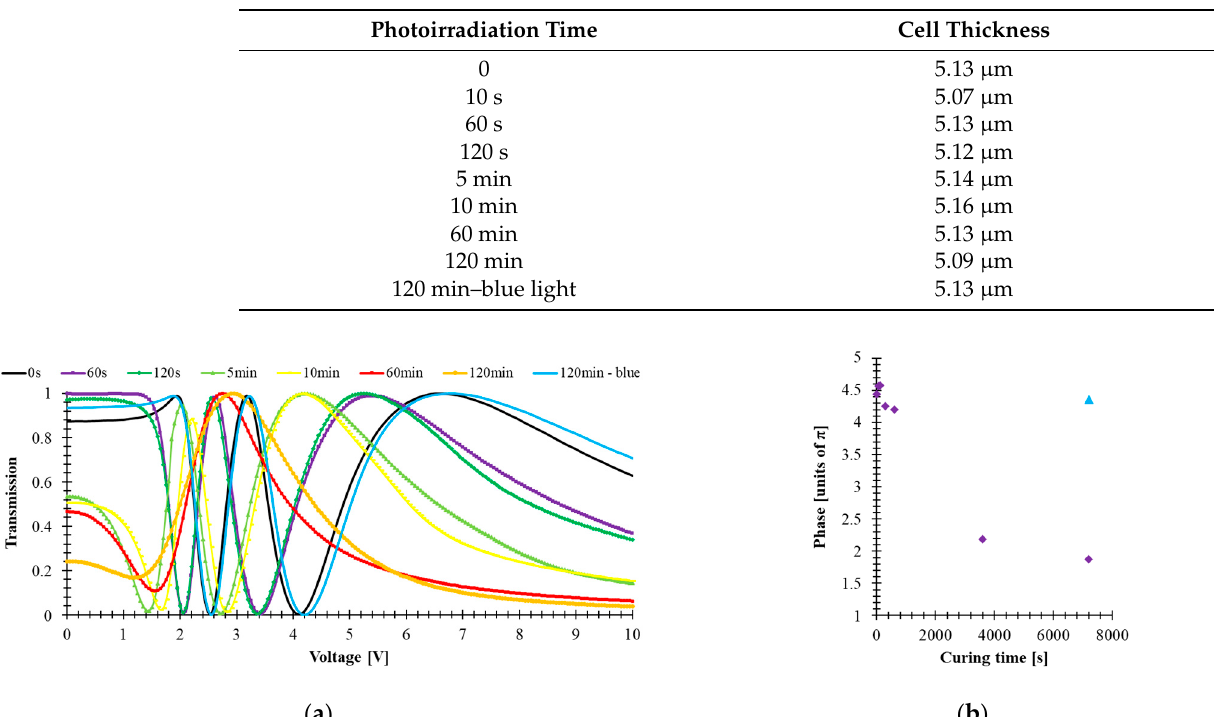
Table 1. Thicknesses of LC cells for UV and blue light stability test.